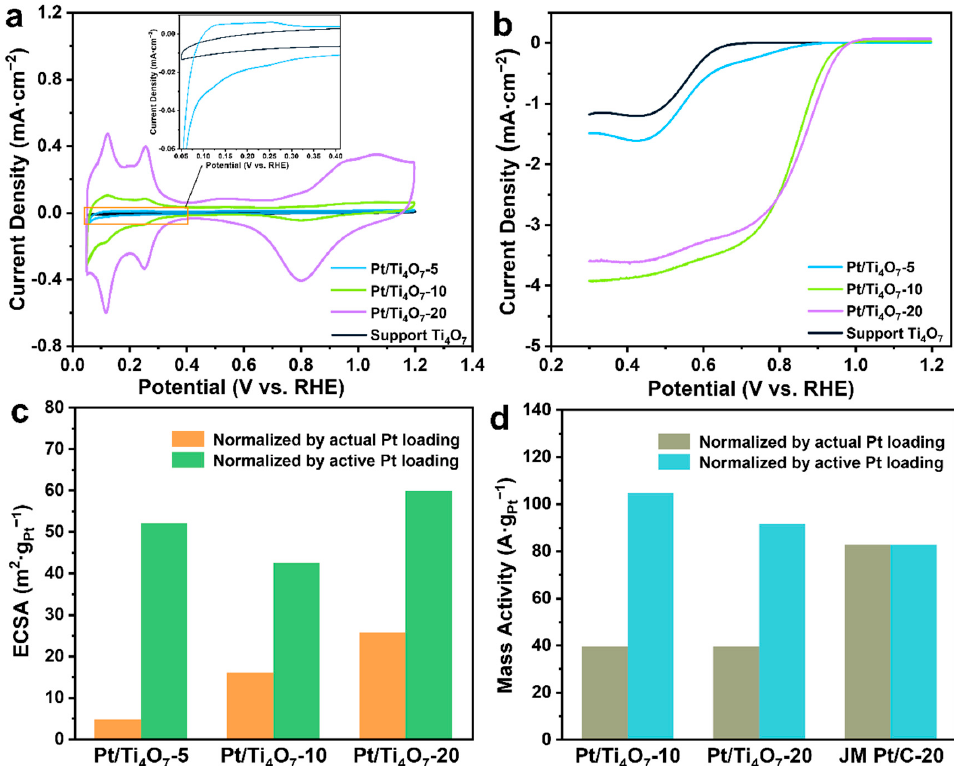
Figure 6. ( a ) The CV curve of support Ti 4 O 7 and series Pt/Ti 4 O 7 in N 2 saturated 0.5 M H 2 SO 4 aqueous solution, scan rate: 50 mV·s − 1 ; ( b ) The LSV curve of support Ti 4 O 7 and series Pt/Ti 4 O 7 in O 2 saturated 0.1 M KOH aqueous solution, scan rate: 10 mV·s − 1 ; ( c ) The ECSA and corrected ECSA values of Pt/Ti 4 O 7 catalysts derived from the CV curves. ( d ) The MA and corrected MA of Pt/Ti 4 O 7 -10, Pt/Ti 4 O 7 -20, and JM Pt/C-20 towards ORR, calculated from the current density at 0.9 V vs. RHE.